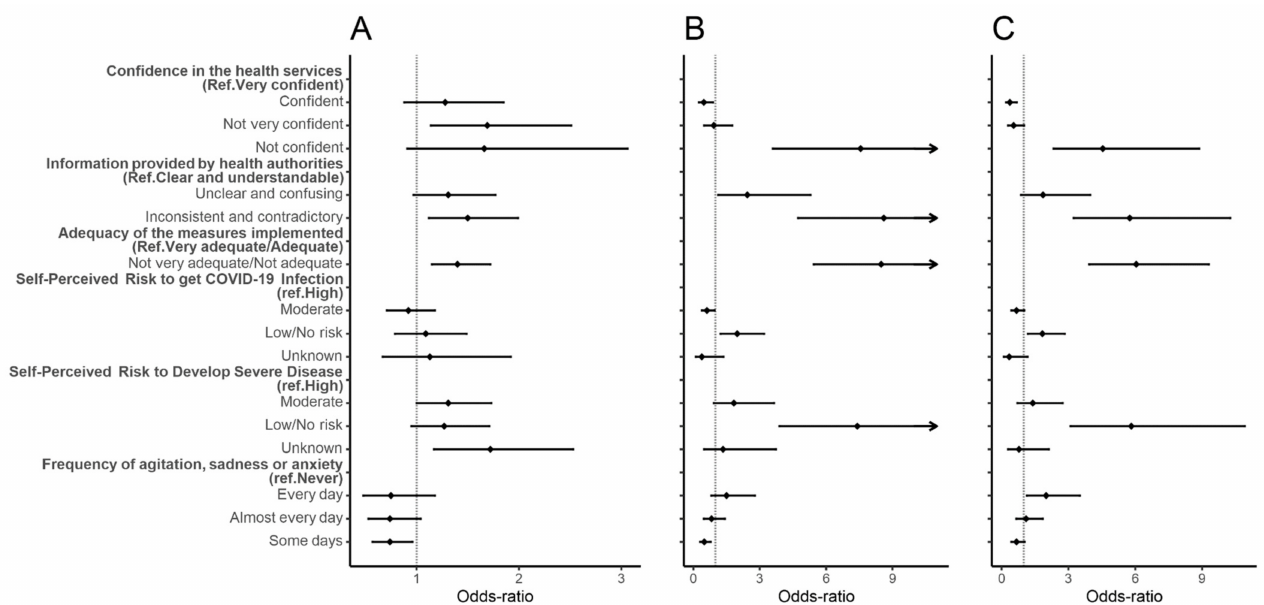
Figure 3. Forest plot of vaccine hesitancy for COVID-19-specific factors. Adjusted odds-ratio (adjusted for gender, age, education, and period of questionnaire) and the respective 95% confidence intervals are denoted by black dots and black lines, respectively. Forest plot confidence intervals and estimates were cut off at 10. ( A ) Individuals who would wait to take the vaccine compared to individuals who would take the vaccine; ( B ) individuals who would not take the vaccine compared to individuals who would take the vaccine; ( C ) individuals who would not take the vaccine compared to individuals who would wait to take the